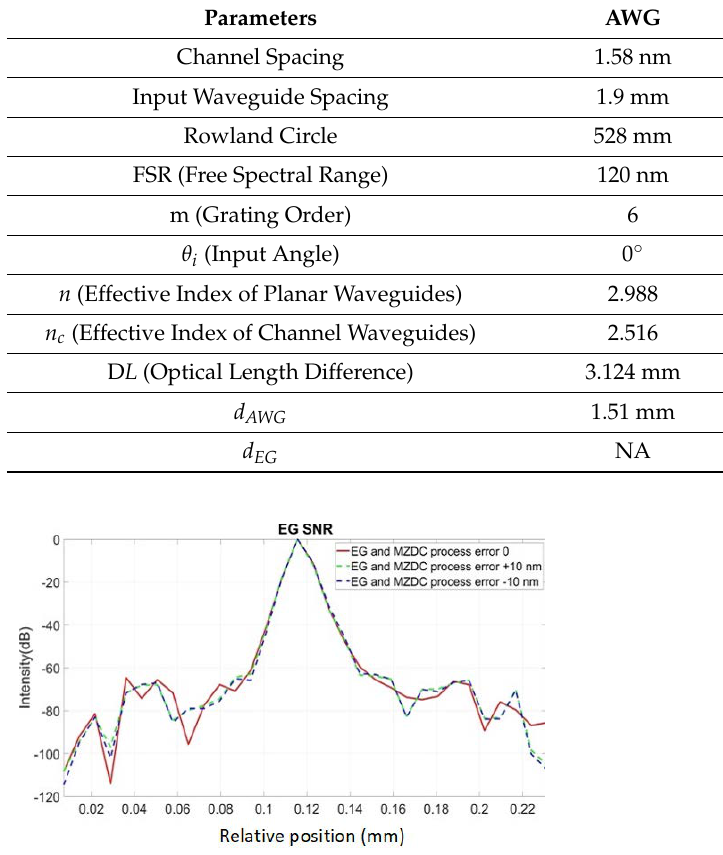
Figure 14. PSF roll-off from the MZDC interrogated with AWG. Figure 15. PSF roll-off from the MZDC interrogated with EG. 4. Conclusions To make the free-space SD-OCT system highly integrated, we replaced the fiber-type coupler and diffraction grating by MZDC and EG or AWG on a silicon chip, so that the bar and cross side of MZDC can be output to the sample and reference arms. Then, the coupler-based SD-OCT system executes the Michelson interferometer and accepts the re- flected beams from the same sides. At the same time, we found that the spectrum of the reflected beam entering the MZDC from the bar and cross ends is not flat again, so we compensated for this via the 64-channel EG spectrum response, which is insensitive to the process variation. After the PSF simulation, we can observe that the SNR of MZDC com- bined with AWG is as high as 61.3 dB without process error. Still, after considering the process error, the SNR performance drops significantly to about 39.3 dB. The SNR simu- lation result of MZDC interrogated with EG shows that the SNR performance can be main- tained at a great 64.5 dB with or without process error, so the SNR of MZDC combined with EG is less sensitive to the process errors. Author Contributions: Conceptualization, S.-H.H. and M.T.; methodology, H.-Y.Z., B.-L.C., and H.- Y.L.; software, H.-Y.Z., B.-L.C., and H.-Y.L.; validation, H.-Y.Z. and B.-L.C.; formal analysis, S.-H.H.;